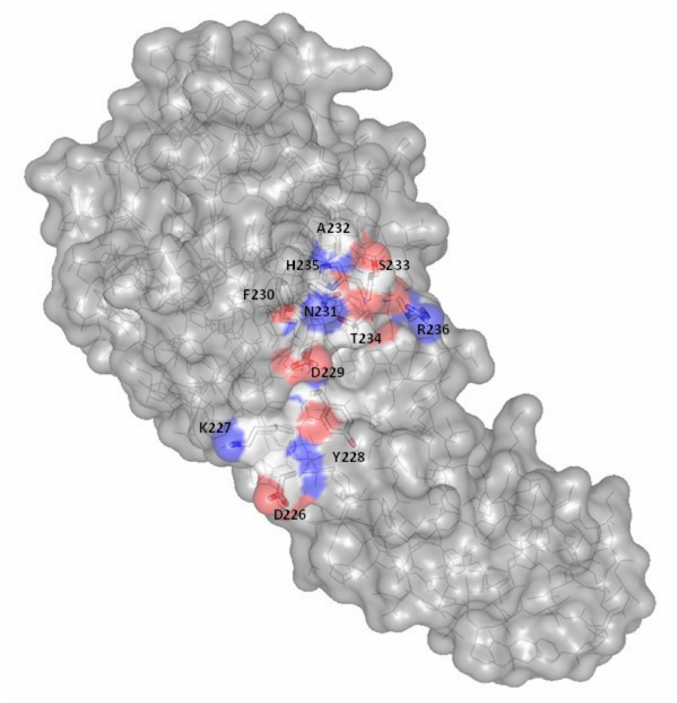
Figure 7. Localization of the active site residues on the surface of ColM. Representation in van der Waals surface of the D 226 KYDFNASTHR 236 residues, localized at the surface of ColM. For these residues, a color code has been attributed to the atoms: carbon in white, nitrogen in blue and oxygen in red. The residues are identified through their position in the primary structure as well as through the corresponding one-letter code. The figure was prepared with the atomic coordinates from the PDB (PDB entry: 2XMX) by using PyMOL (DeLano